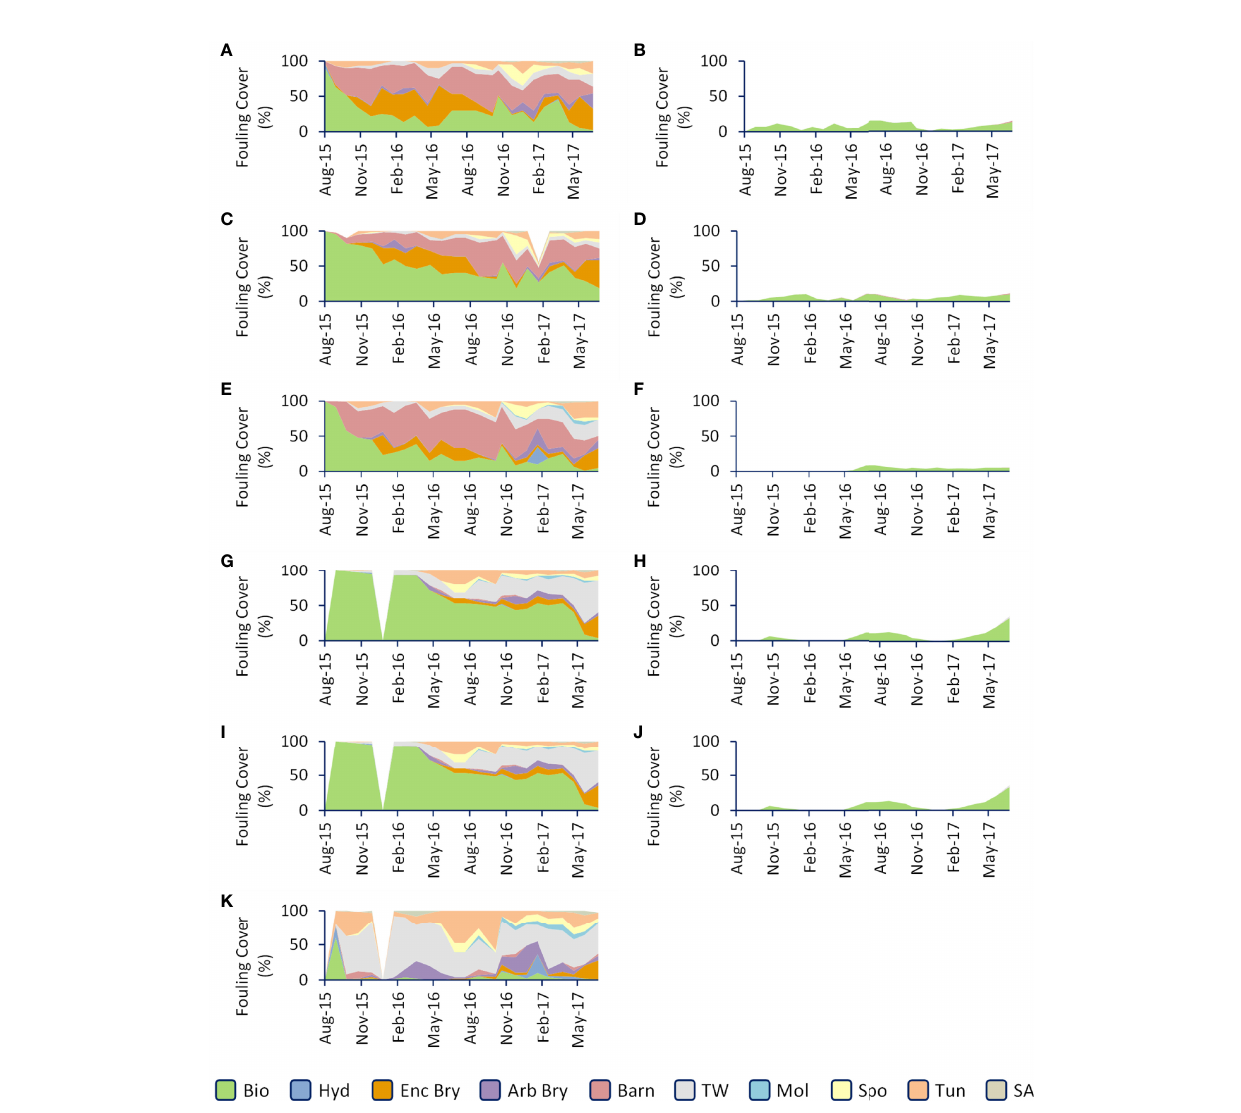
FIGURE 3 | Comparison of fouling composition among the coatings. The left graphs (A, C, E, G, I, K) represent ungroomed surfaces, the right graphs (B, D, F, H, J) represent groomed surfaces. Coating order is as follows: ACA (A, B) , SPC1 (C, D) , SPC2 (E, F) , CF1 (G, H) , CF2 (I, J) and EPX (K) . Bio, Bio fi lm; Hyd, Hydroid; Enc Bry, Encrusting Bryozoan; Arb Bry, Arborescent Bryozoan; Barn, Barnacle; TW, Tube Worm; Mol, Mollusc; Spo, Sponge; Tun, Tunicate; SA, Sea